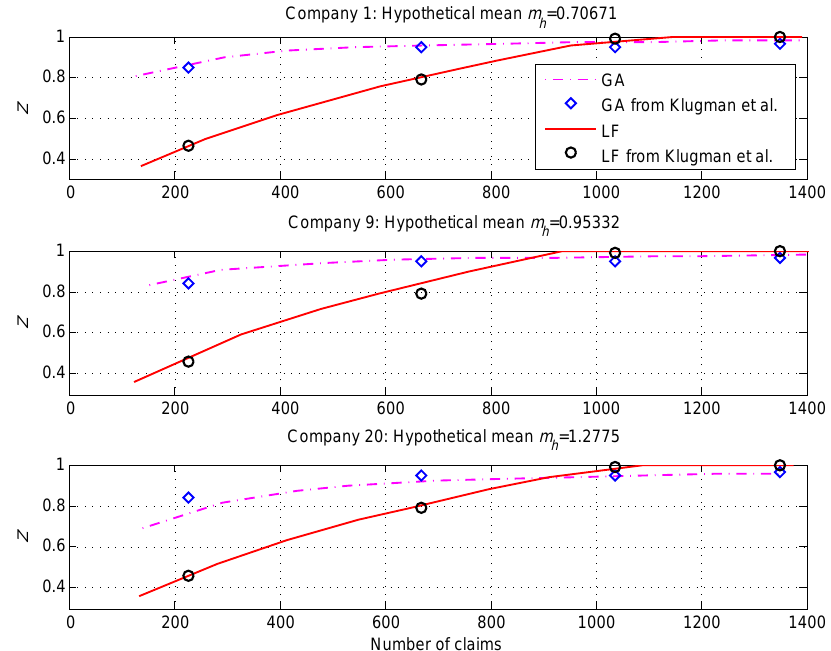
Figure 1. We show the limited fluctuation (LF) and greatest accuracy (GA) credibility factors for three “companies” (risk classes) from our simulated data set and contrast our results with the results from (Klugman et al. 2009), which are based on real data. The results are remarkably